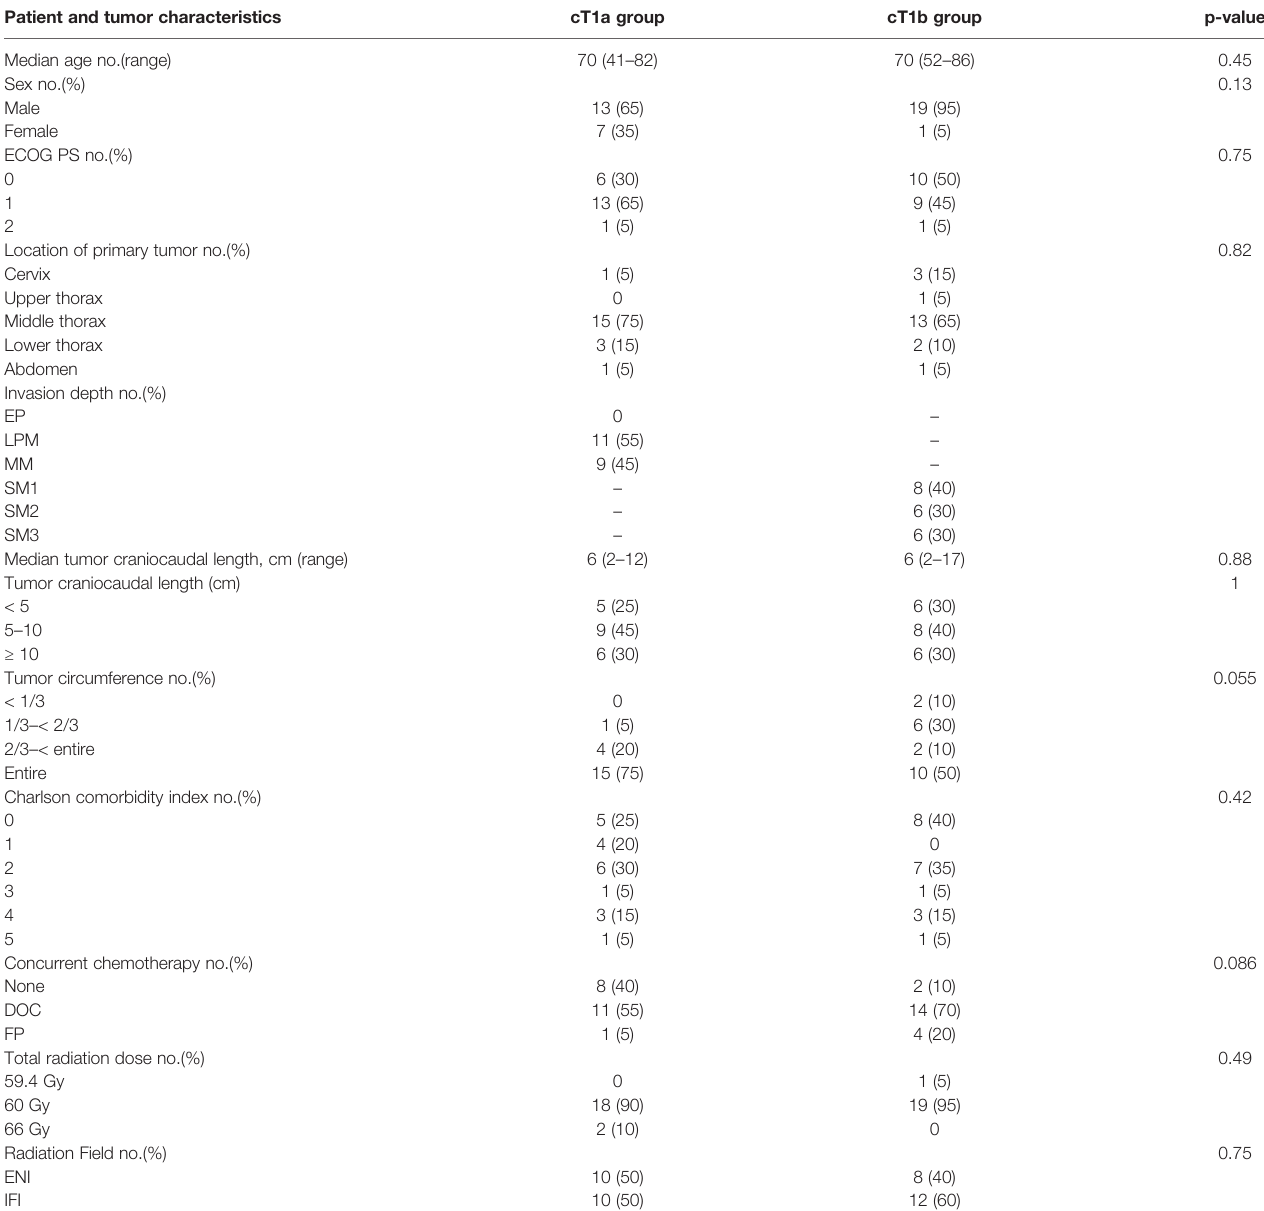
TABLE 1 | Patient and tumor